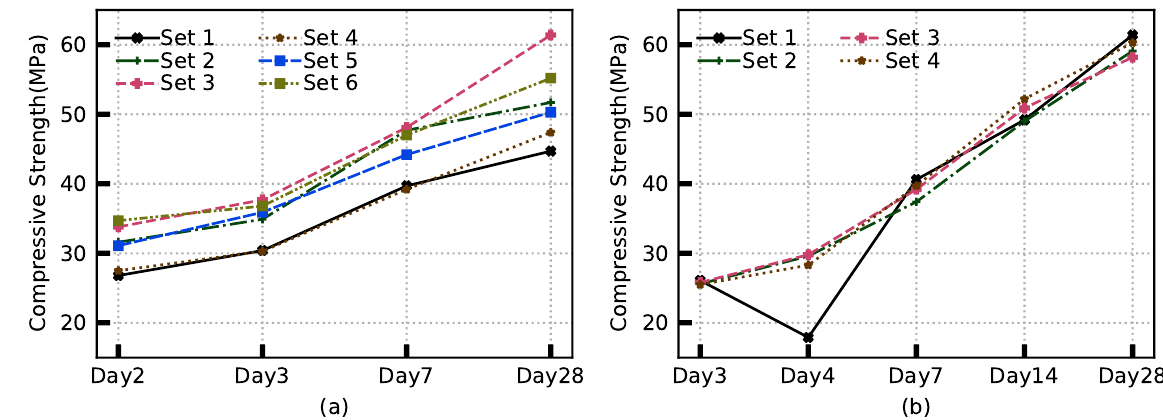
Figure 5. ( a ) Compressive strength for the August pours (NE and main span.) ( b ) Compressive strength for the October pour (SE